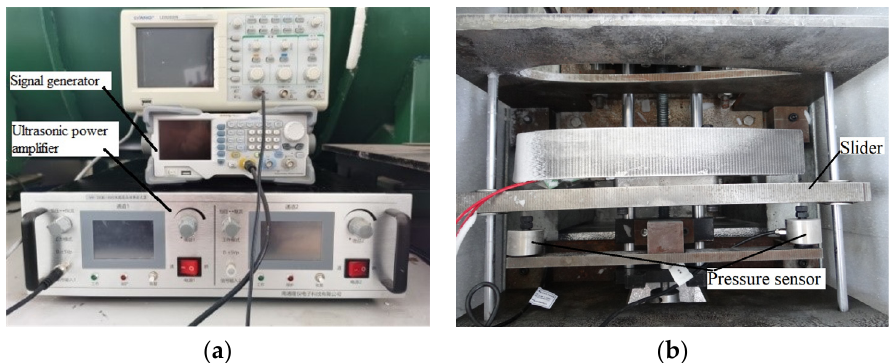
Figure 9. Ultrasonic de-icing sub-system. ( a ) Ultrasonic excitation device; ( b ) Adhesion measure- ment device.